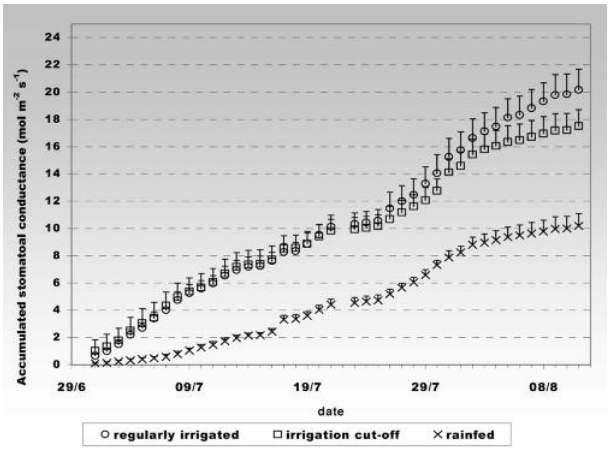
Figure2. Accumulated stomatal conductance of processing tomato in the three different treatments during the measuring period, based on data recorded at 1PMVertical bars represent significant differences at p=0.05 (n=4).